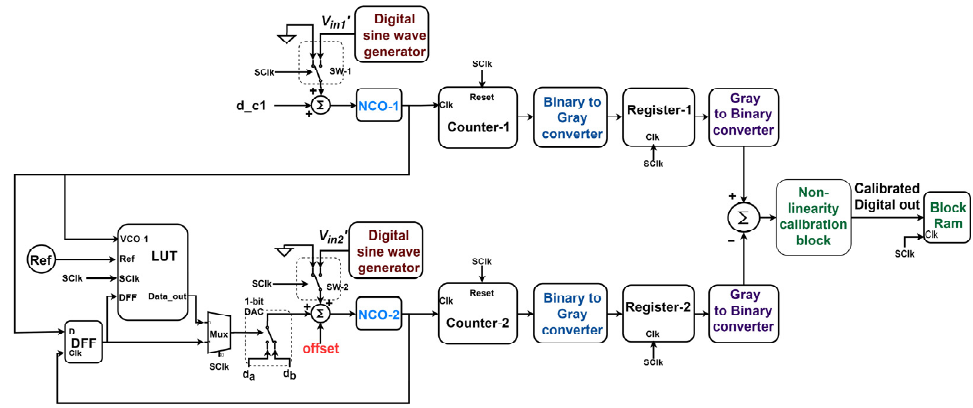
Figure 9. Full implemented architecture.